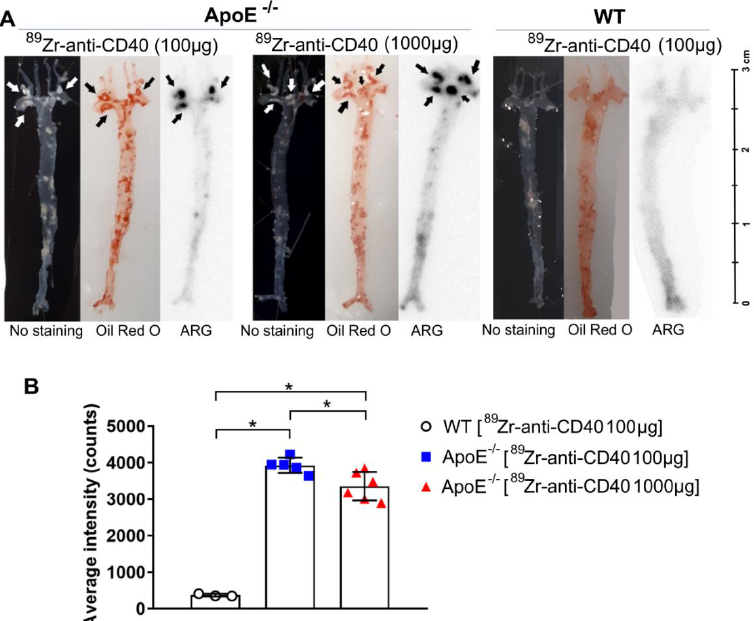
Figure 5. Autoradiography and Oil Red O staining of en face aortic arches demonstrate the specific binding of [ 89 Zr]Zr-anti-CD40 mAb to plaque areas. ( A ) Autoradiography and Oil red O staining in both an ApoE −/− and WT mouse. Arrows indicate plaque regions. ( B ) Quantification of autoradiography intensity in all groups. * p < 0.05; WT N = 3, ApoE −/− “low dose” N = 5, ApoE −/− “high dose” N = 6.